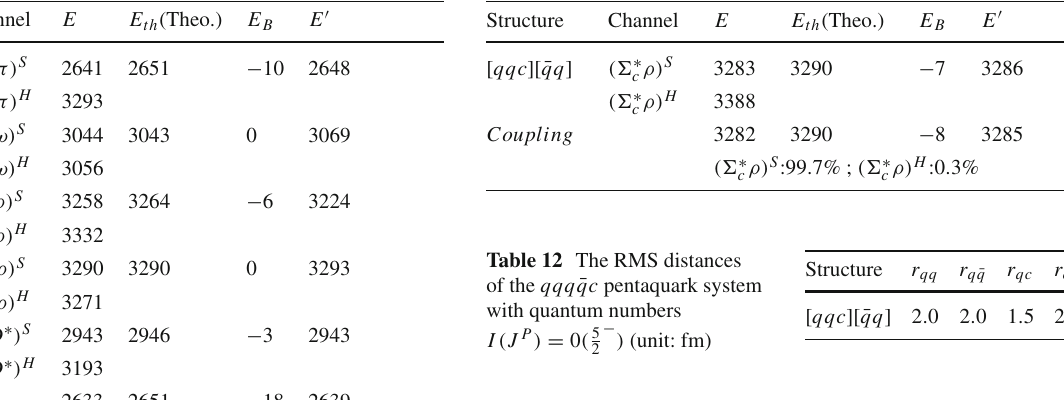
Table 8 The energies of the qqq ¯ qc pentaquark system with quantum